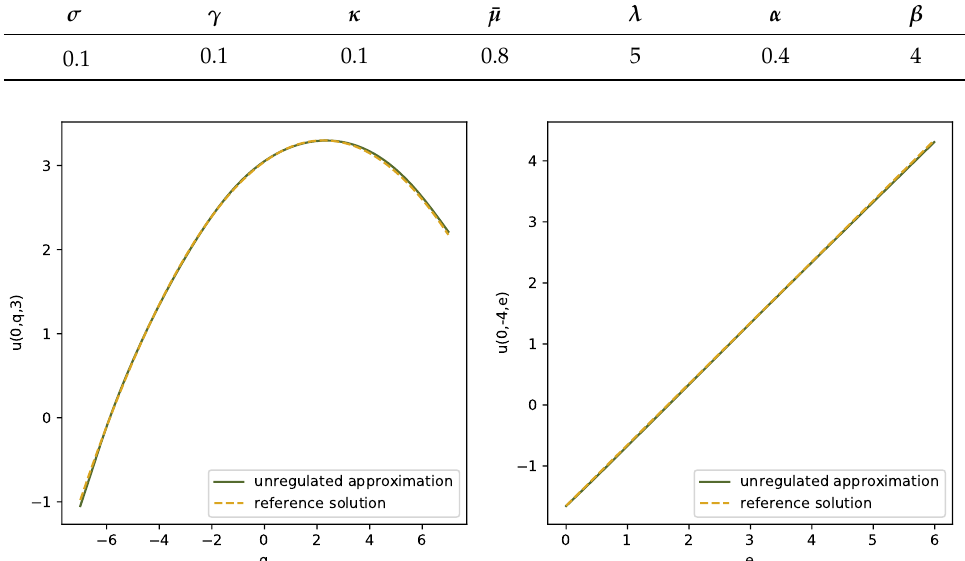
Table 3. Parameters for the credit optimization problem.